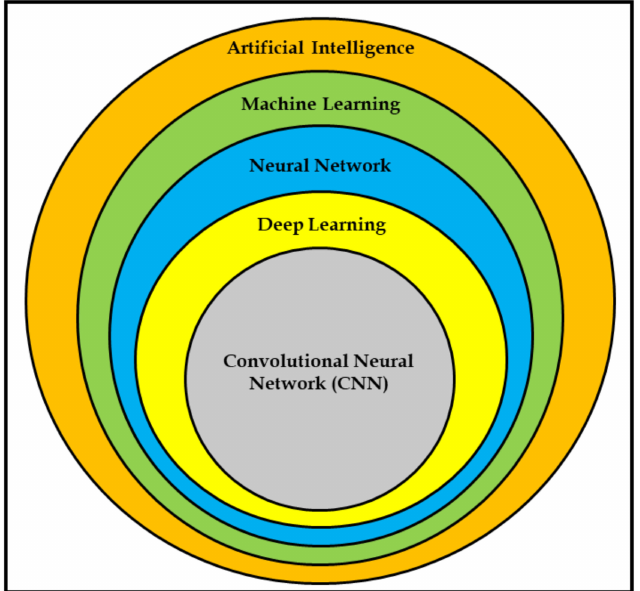
Figure 1. Hierarchical architecture of artificial